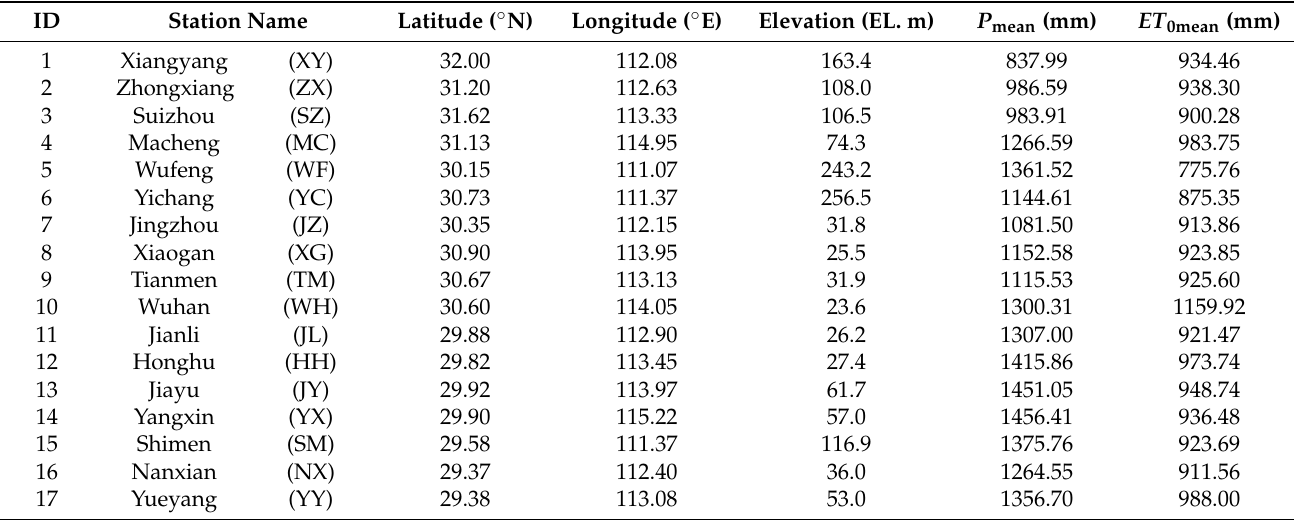
Table 1. Summary 1 of the weather stations where meteorological data were obtained for the